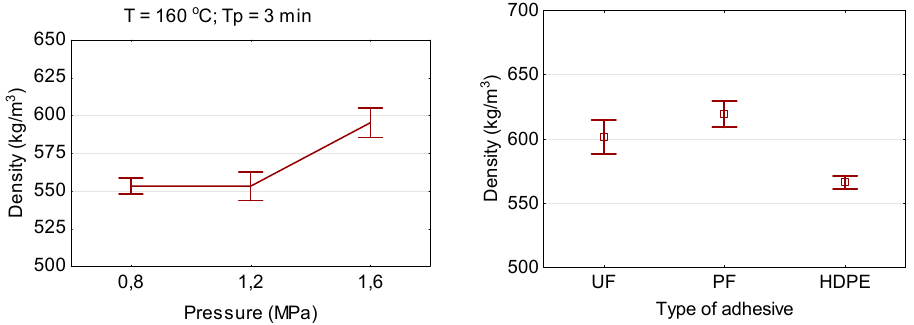
Figure 2. Relationship between the thickness and density of plywood and hot-pressing parameters.